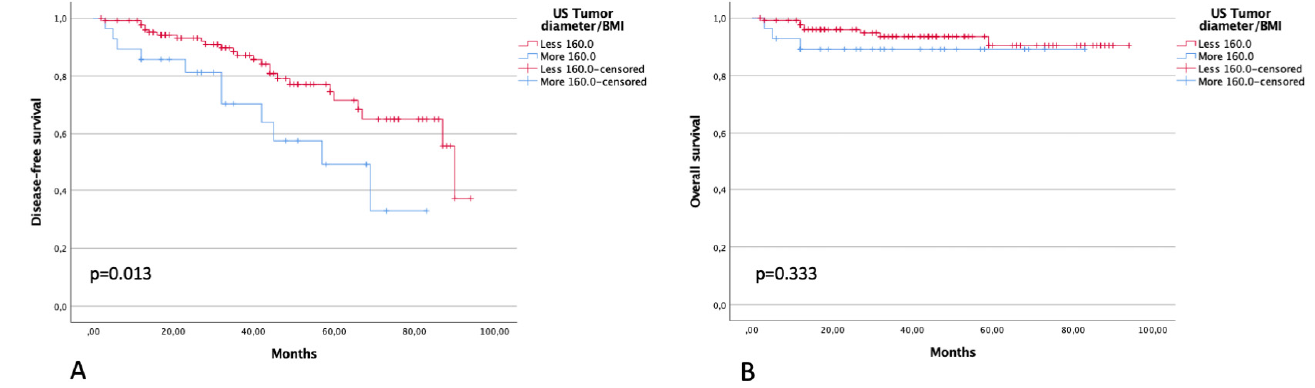
Figure 5. DFS ( A ) and OS ( B ) in patients with a ratio between largest tumor diameter at of ≤ 160 and >160.